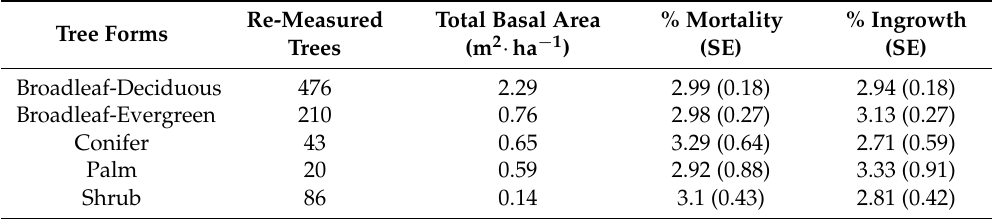
Table 2. Basal area and average annual urban forest percent mortality and ingrowth for different tree forms in Santiago, Chile during 2002 to 2014.